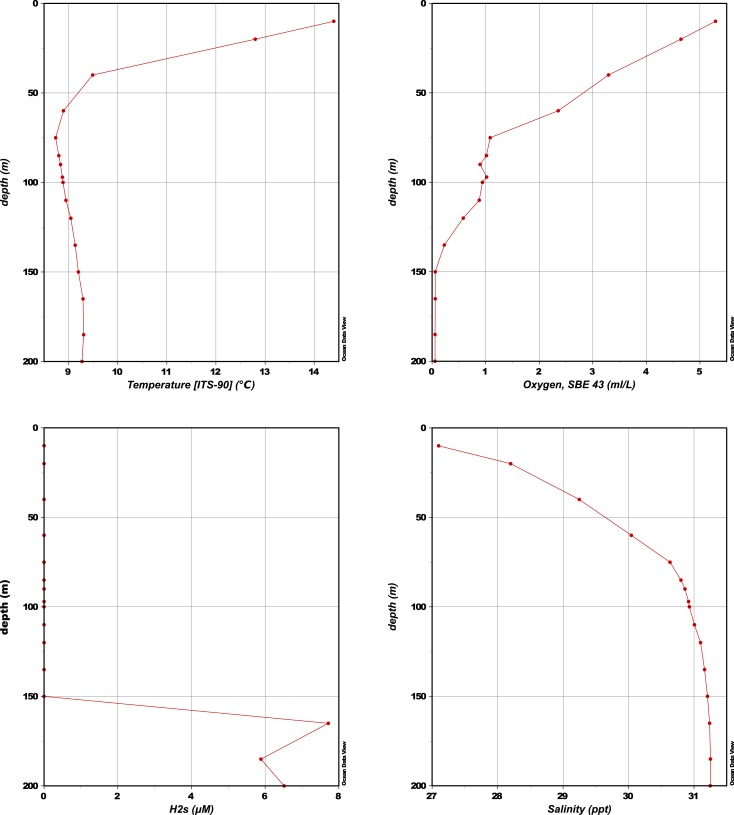
CTD measurements of oxygen concentration, temperature, salinity, and H2S concentration in the water column of Saanich Inlet at the time of sampling (August 2011).